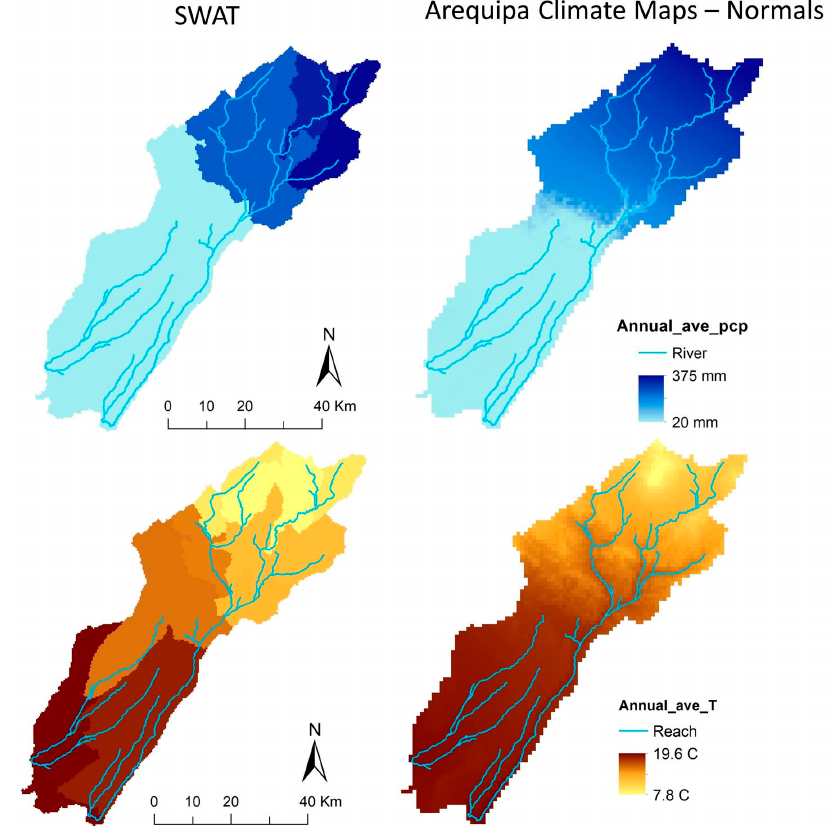
Figure A1. Arequipa Climate Maps-Normals.